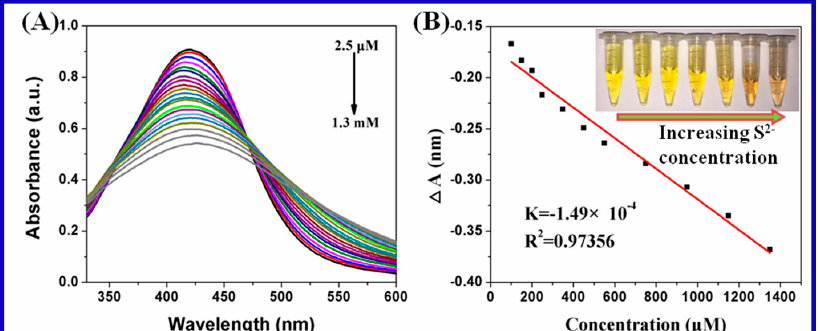
Figure 8. ( A ) UV-Vis absorption spectral of carrageenan-AgNPs with various amounts of S 2 − . ( B ) The plot of relative absorption intensity ( Δ A) vs. different concentrations of S 2 − .